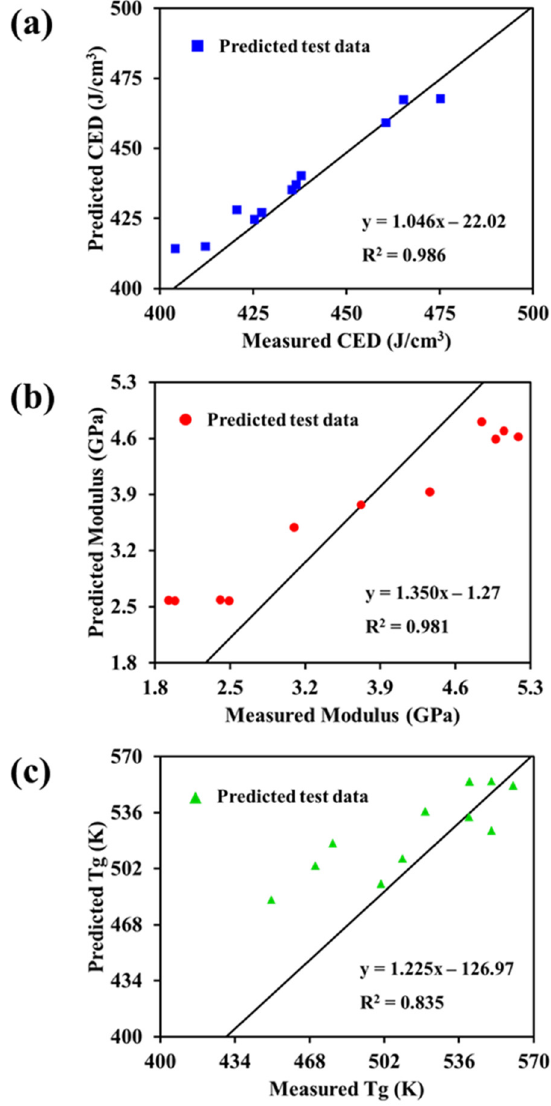
Figure 5. ( a ) Correlation of cohesive energy density predicted by ANN with actual cohesive energy density, ( b ) correlation of modulus predicted by ANN with actual modulus, and ( c ) correlation of glass transition temperature predicted by ANN with actual glass transition